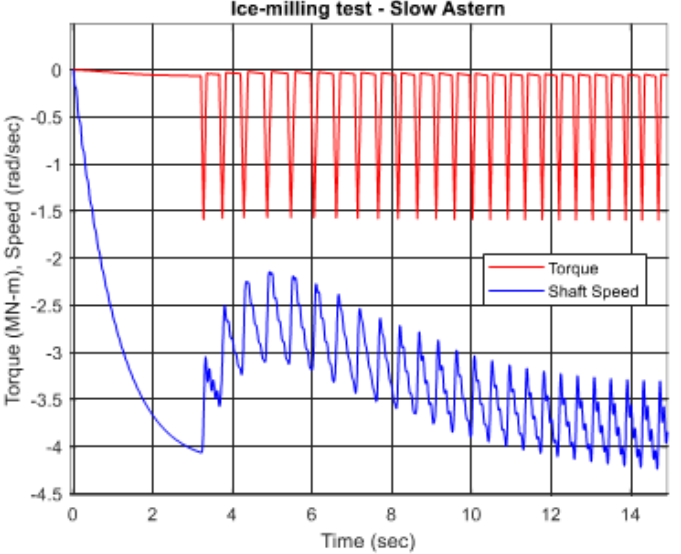
Figure 16. Ice Milling Shaft Speed and Torque—Slow Astern Operation.